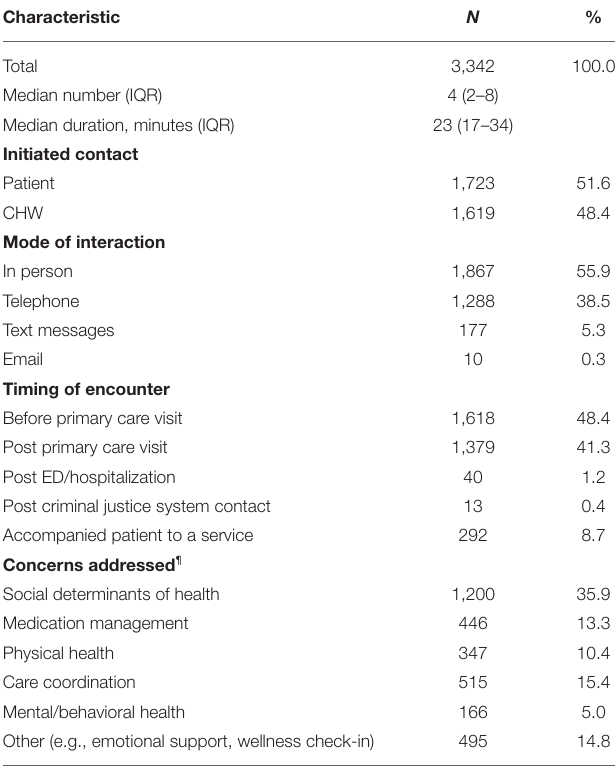
TABLE 2 | Characteristics of CHW encounters within 6 months of establishing care with the TCN ( N = 547). Characteristic